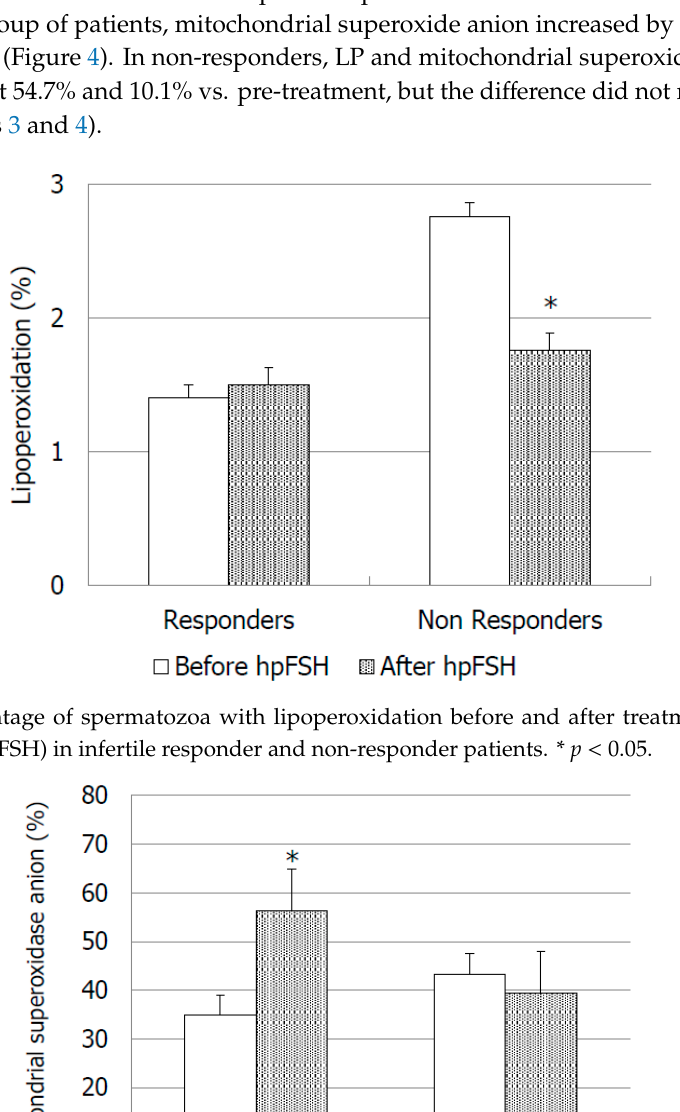
Figure 2. Bio ‐ functional sperm parameters before and after treatment with high purified FSH (hpFSH) in infertile non ‐ responder patients. * p < 0.05